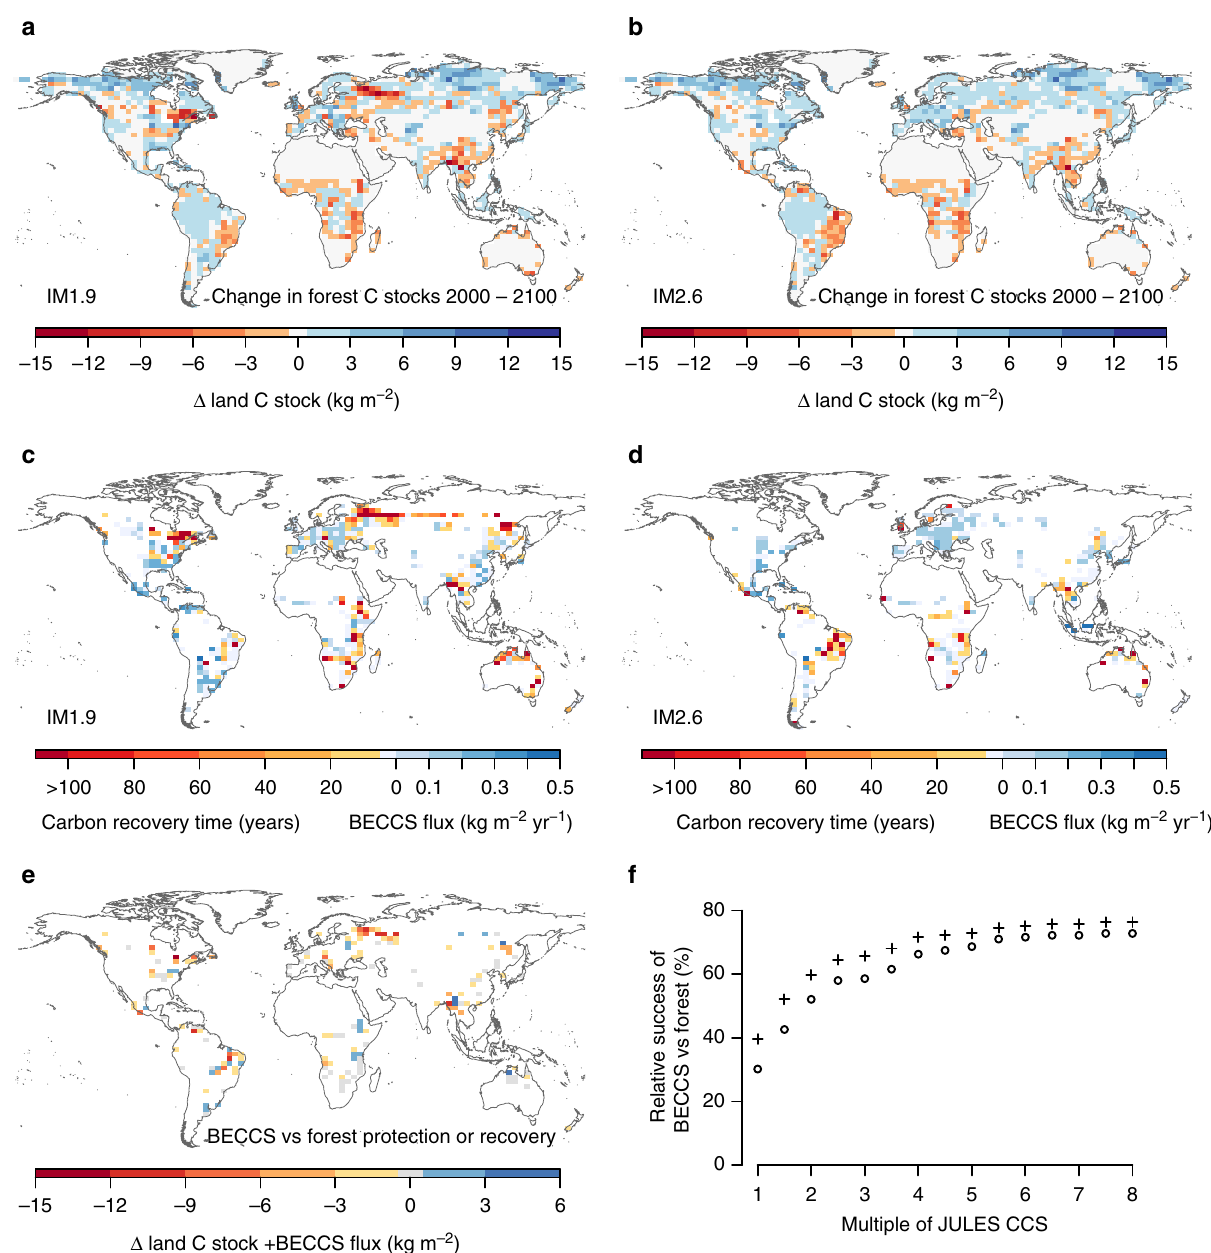
Fig. 6 Comparison of forests and bioenergy crops with carbon capture and storage for carbon storage based on JULES simulations. a , b Change in forest carbon stocks over the 21st century (vegetation, soils and woody product pools) for the 1.5 °C climate scenario with IM1.9 and IM2.6 land use patterns. c , d Recovery time for BECCS. Blues indicate the recovery time is 0 years, and instead shows the mean annual fl ux of captured carbon via BECCS. e Difference in total carbon stocks (including accumulated storage via BECCS) at 2100 on grid cells where the two scenarios have con fl icting land-use change. The convention is: scenario with bioenergy crops minus scenario with forests, such that blues indicate more carbon stored with BECCS and reds indicate more carbon stored with forests. f The percentage of points in e , in which BECCS is more successful at accumulating carbon than forest preservation or reforestation, showing the effect of increasing the default carbon storage from BECCS in JULES. Crosses indicate the bene fi t of harvesting initial aboveground biomass for BECCS as in